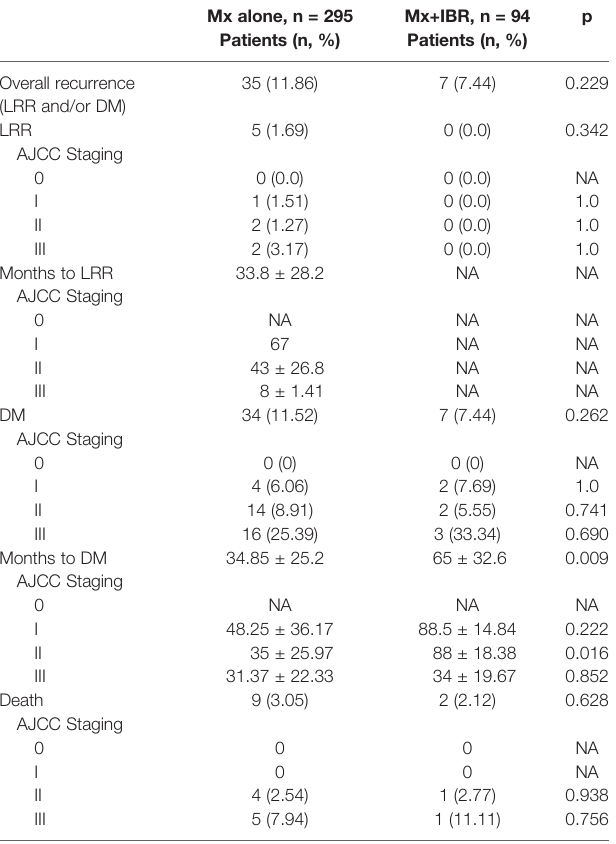
TABLE 3 | Locoregional recurrence and distant metastasis by AJCC staging in the cohort of patients.